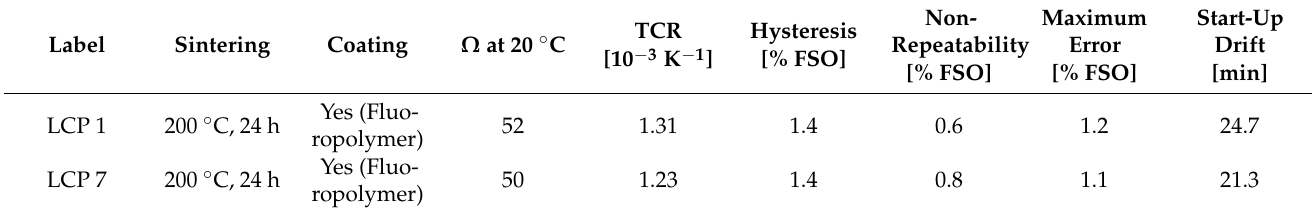
Table 4. Important properties of the two best presented printed